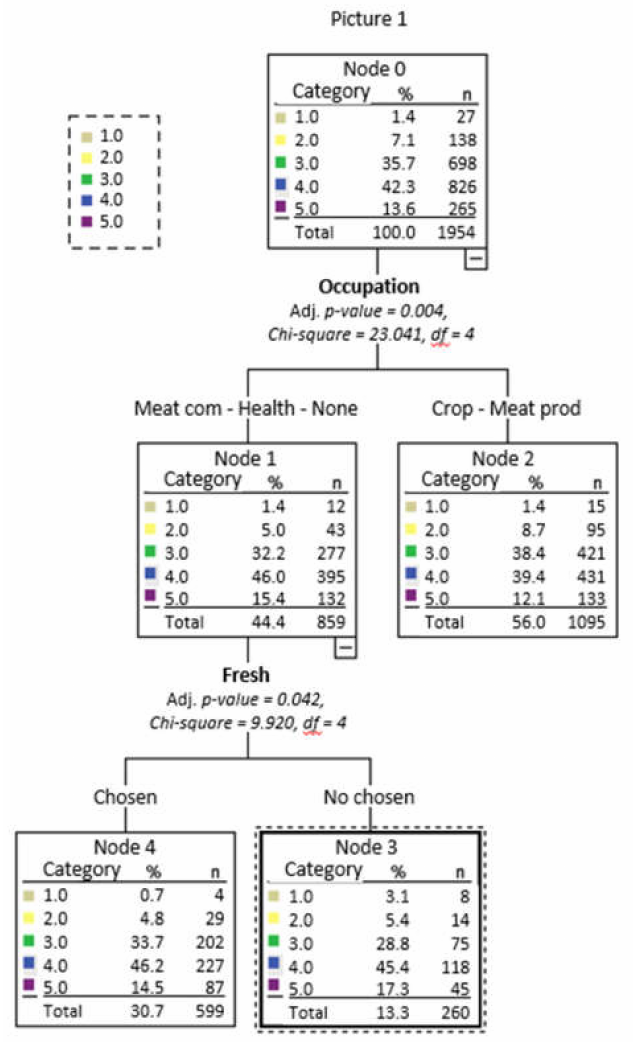
Figure 3. Decision tree for Picture 1 as a function of sociodemographic variables, purchase habits, beliefs and the criteria used in the